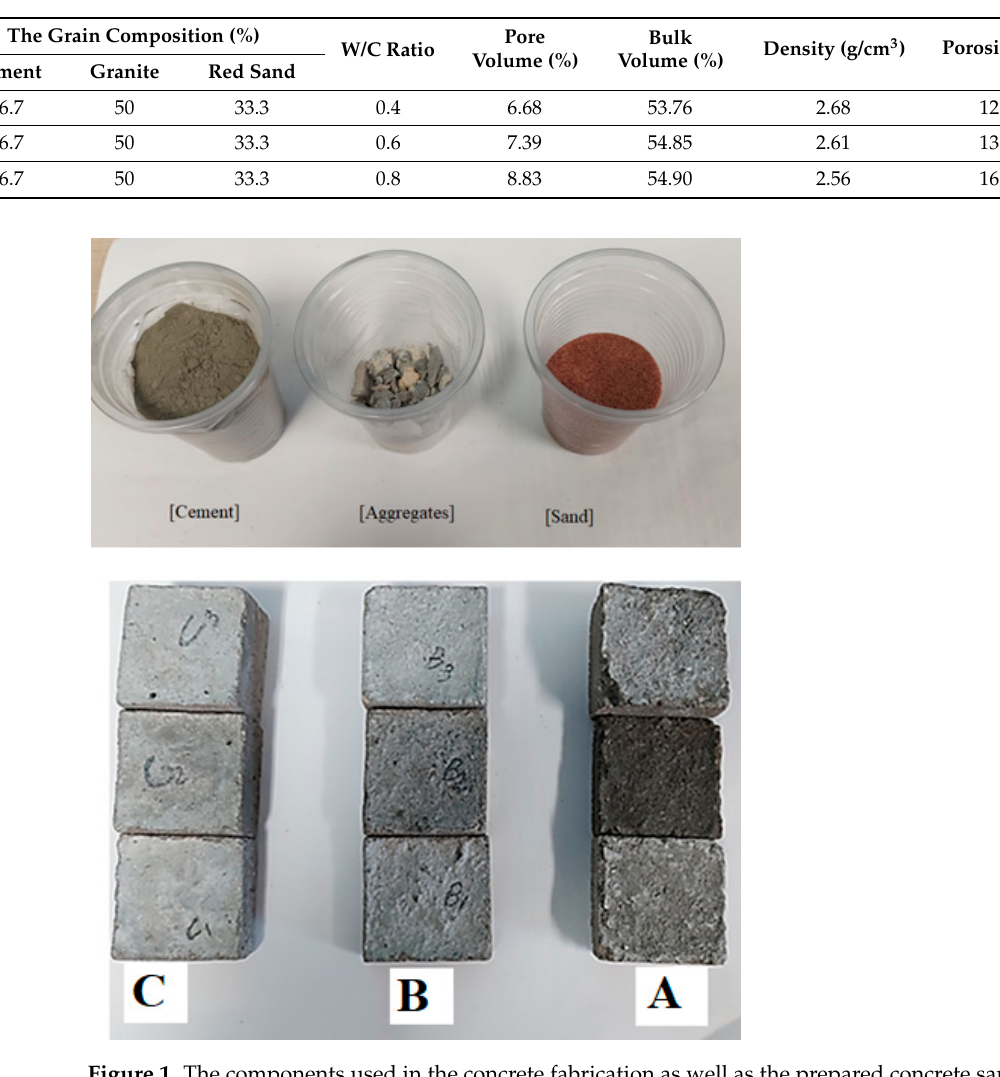
Figure 1. The components used in the concrete fabrication as well as the prepared concrete sample C, B, A with W/C ratio of 0.8, 0.6, and 0.4, respectively. Table 1 . The concrete constituent component ratios, density, and porosity of the fabricated concrete